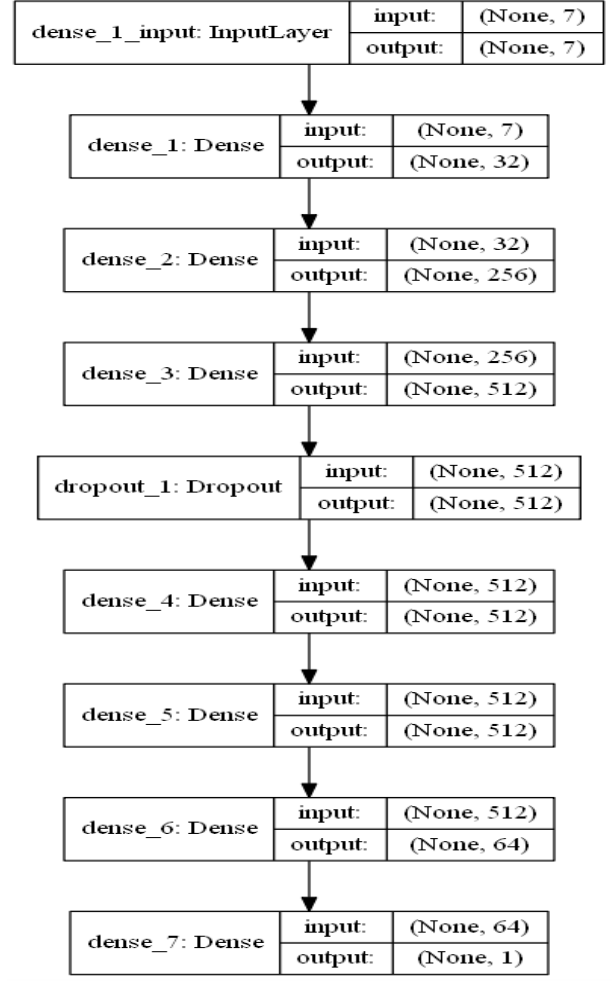
Figure 3. Illustration of the proposed Deep Neural Network (DNN) for rainfall erosivity (R-factor) prediction.